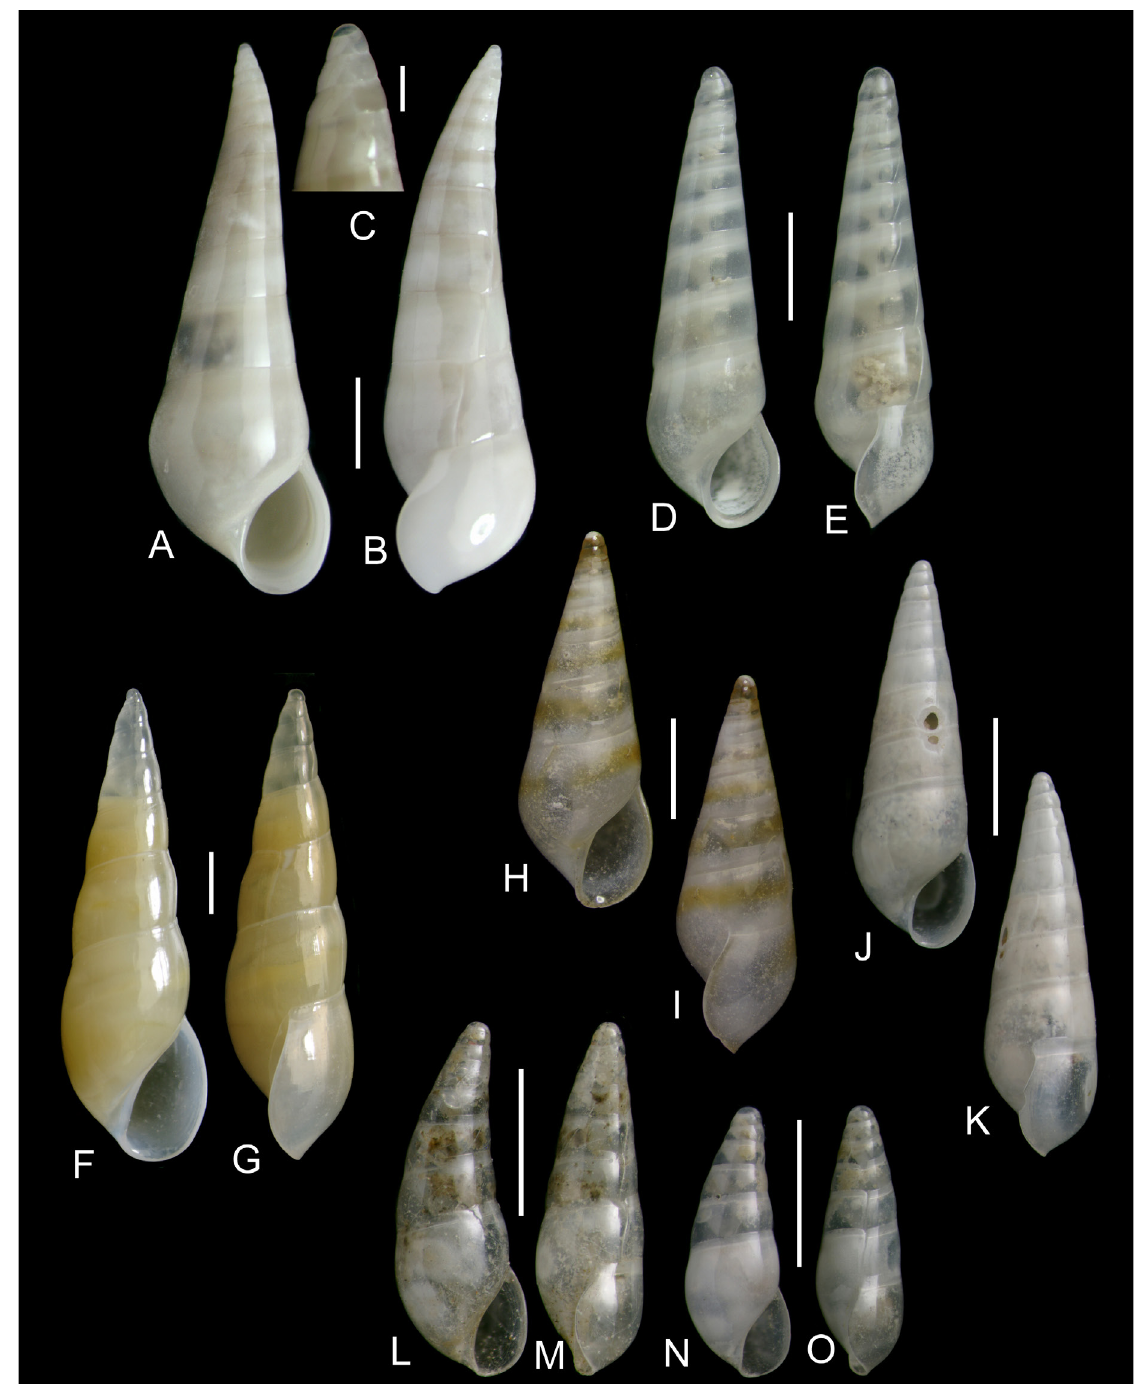
Fig. 19. Eulimidae 1. A–C . Melanella spiridioni (Dautzenberg & H. Fischer, 1896) and detail of protoconch, BANGAL 0711, V5, 1631 m, 6.0 mm. D–E . Melanella jeffreysi (Tryon, 1886), BANGAL 0711, V2, 1706 m, 4.3 mm. F–G . Melanella cf. myriotrochi Bouchet & Warén, 1986, BANGAL 0711, V2, 7.6 mm. H–I . “ Eulima ” leptozona Dautzenberg & H. Fischer, 1896, SEAMOUNT 1, DW111, 675–685 m, 3.8 mm. J–K . “ Eulima ” anonyma Bouchet & Warén, 1986, BANGAL 0711, V2, 3.3 mm. L–O . Eulitoma obtusiuscula Bouchet & Warén, 1986, BANGAL 0711, DR15, 1410 m, 2.4 and 1.85 mm. Scale bar for A–B, D–O = 1 mm; C = 200